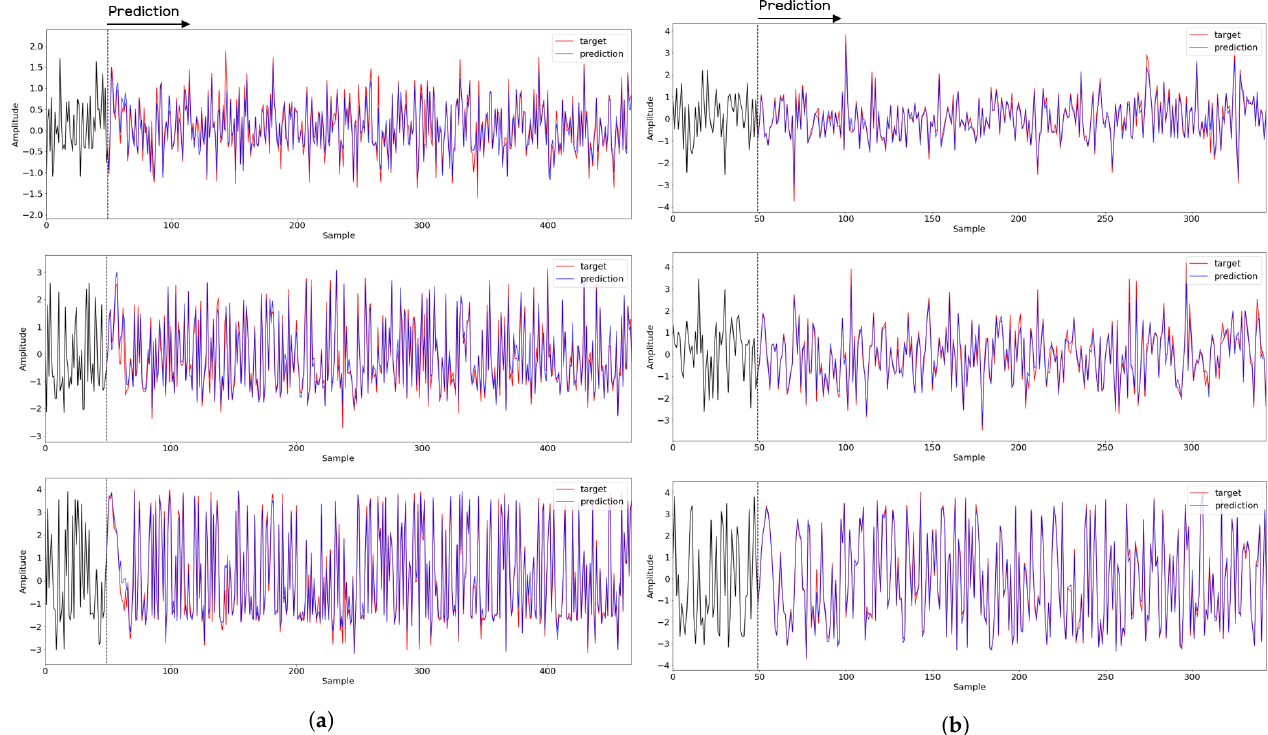
Figure 16. Recovery results for decoder network for ( a ) walking motion and ( b ) running motion. The top, middle, and bottom rows represent the x-, y-, and z-axis, respectively. The blue and red lines indicate the predicted signal from the FNO model and target signal, respectively, and the black line represents the signal corresponding to the input entered into the FNO